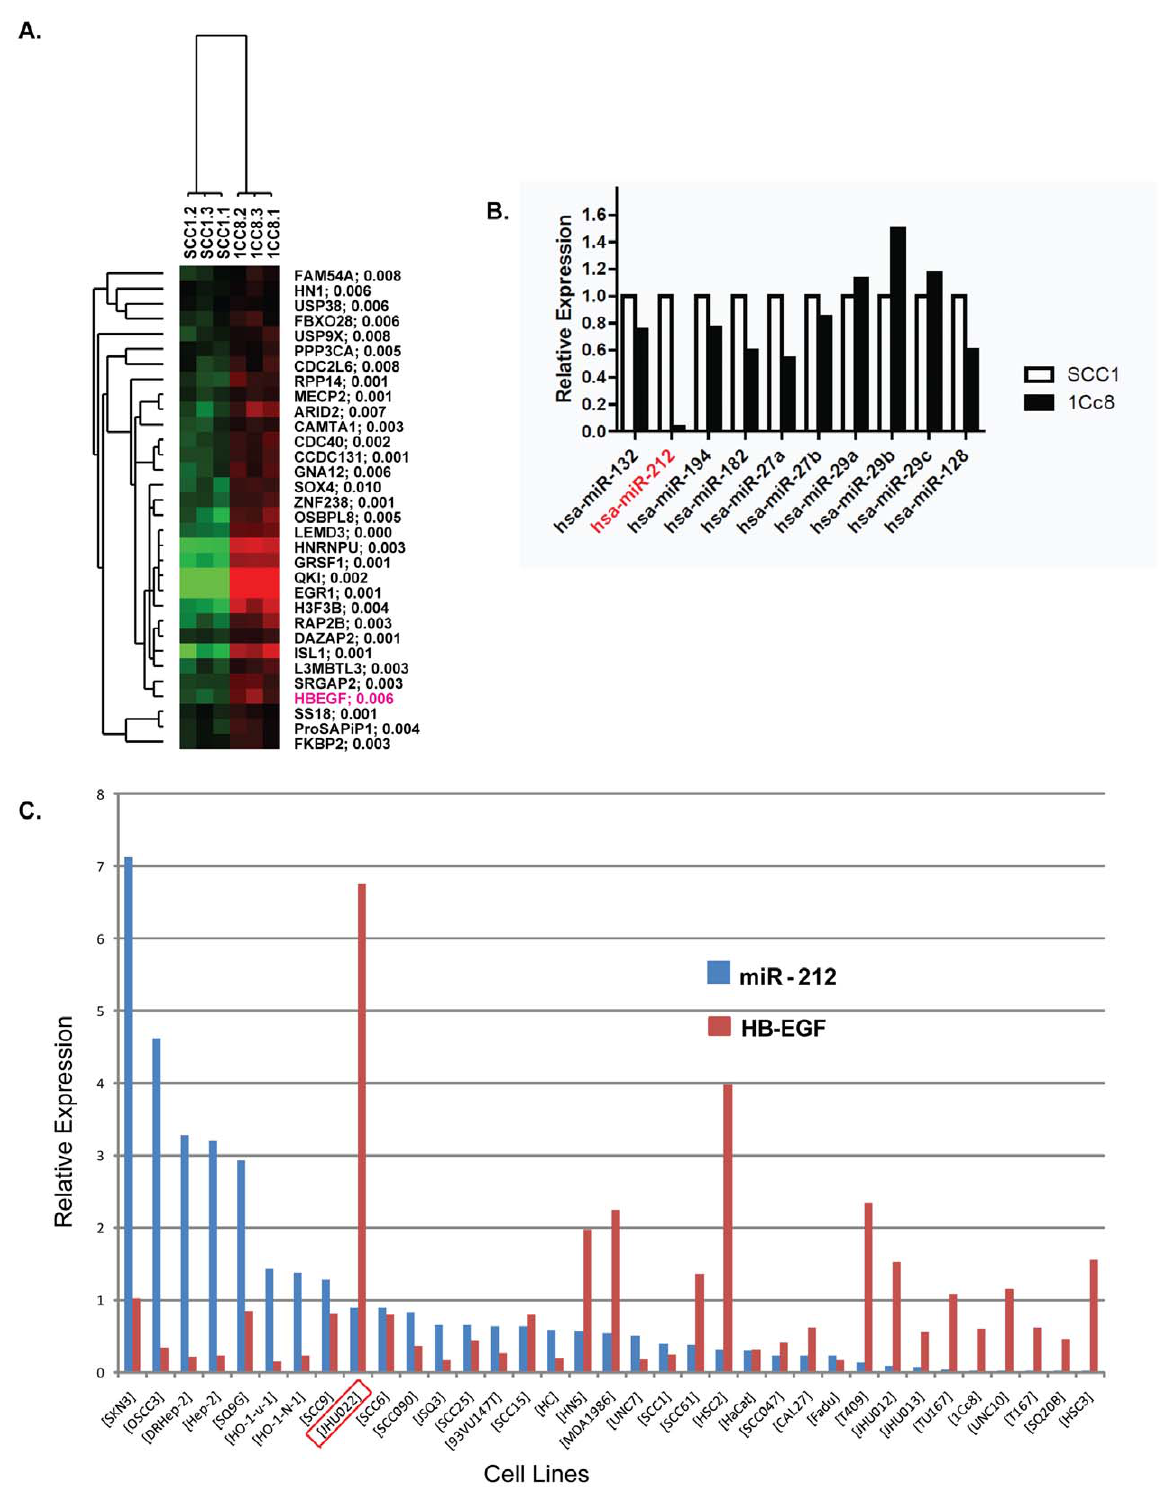
Figure 4. Identification of microRNA-212 as a potential regulator of HB-EGF expression. A) Top 20 genes putatively targeted by miR-212. The numbers next to the gene symbols are p-values. Red: higher gene expression, Green: lower gene expression. B) Relative expression of top 10 miRs targeting HB-EGF in SCC1 and 1Cc8. C) Relative expression levels of miR-212 and HB-EGF in 34 HNSCC cell lines and a keratinocyte cell line. HB- EGF expression data were obtained from DNA microarray analyses and miR-212 expression data were obtained from TLDA microRNA arrays.